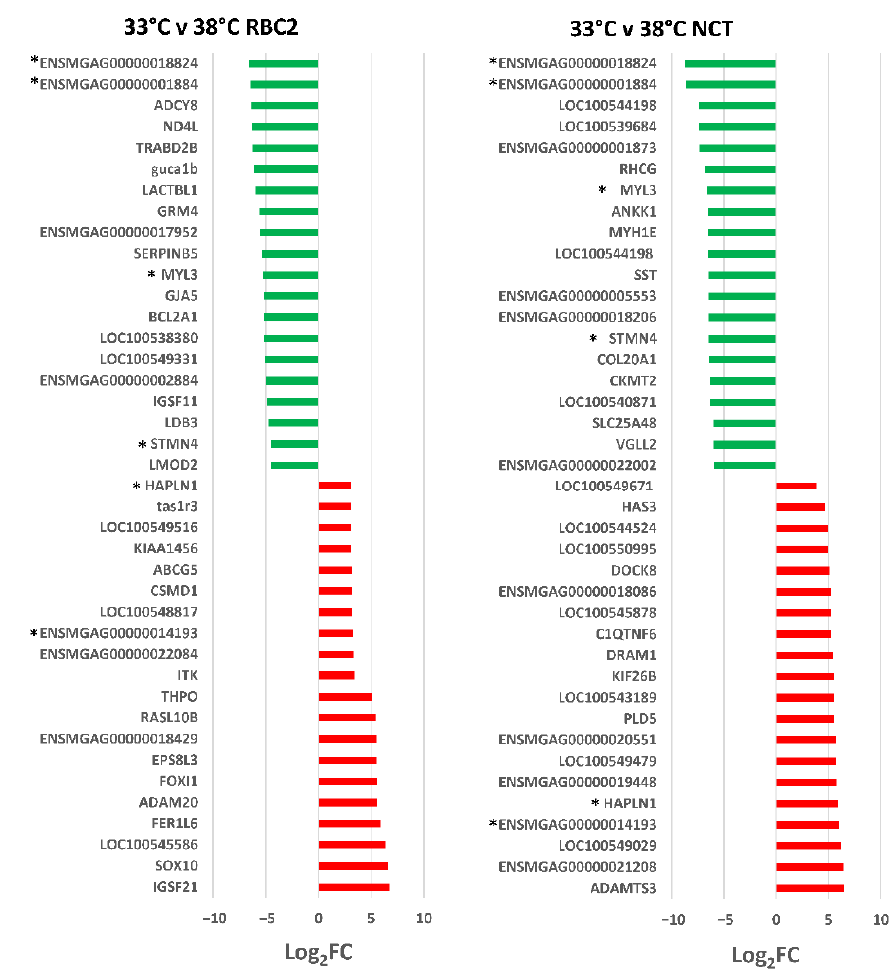
Figure 3. Directional change in the genes showing the highest expression differences in comparison between lines (RBC2 and NCT) at 33 °C and 38 °C. For each with-in temperature comparison the Log 2 FC is plotted is plotted for each DEG (FDR p -value < 0.05). Genes shared between temperatures are indicated by asterisks (*). Directional expression of genes is indicated by red (up) or green (down).